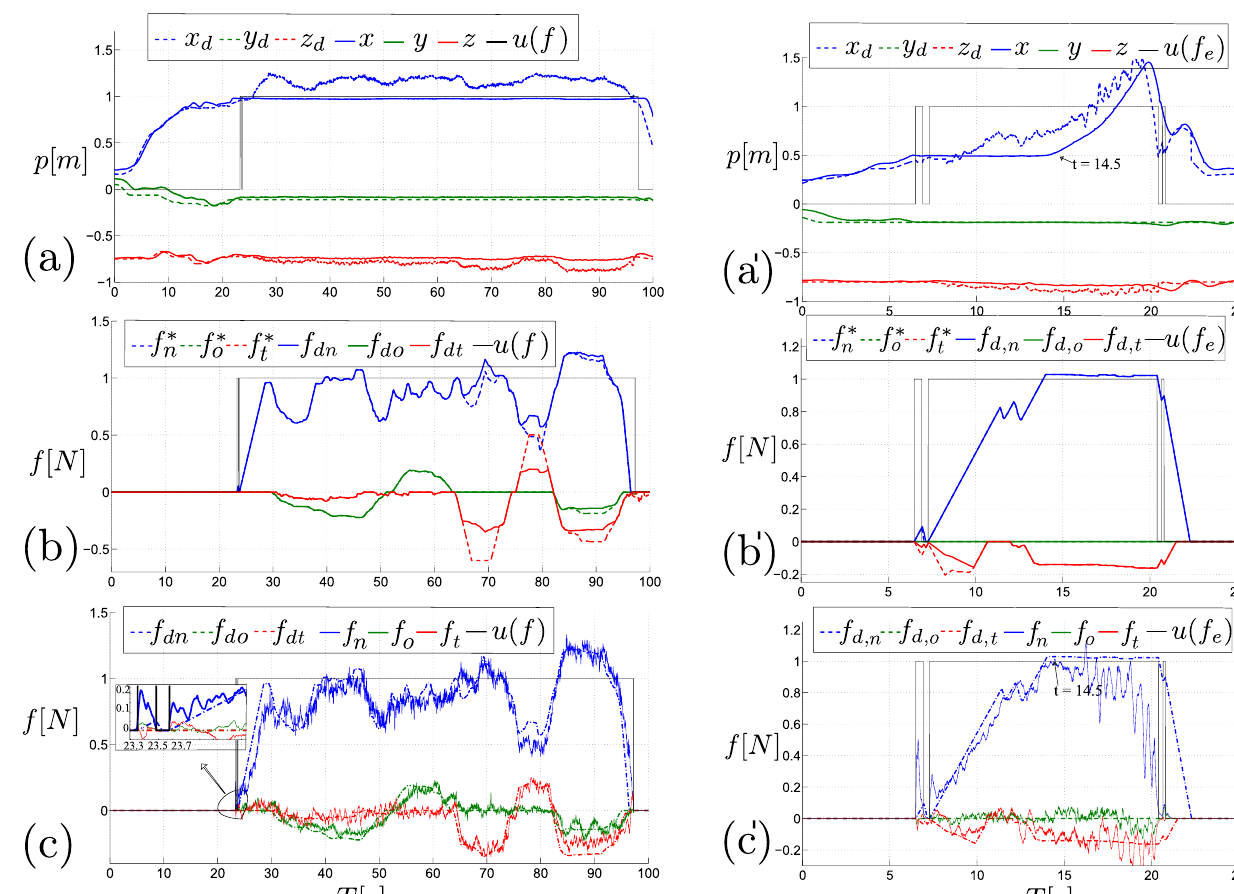
Figure 8. Stationary object experiment ( left ): docking and applying a force commanded by the human operator to a stationary object: ( a ) position tracking, ( b ) contact maintenance, that is, keeping of the desired force within the friction cone, and ( c ) force tracking. Movable object experiment ( right ): docking and applying force to a movable object in order to push it 1 m away: ( a’ ) position tracking, ( b’ ) contact maintenance, that is, keeping of the desired force within the friction cone, and ( c’ ) force